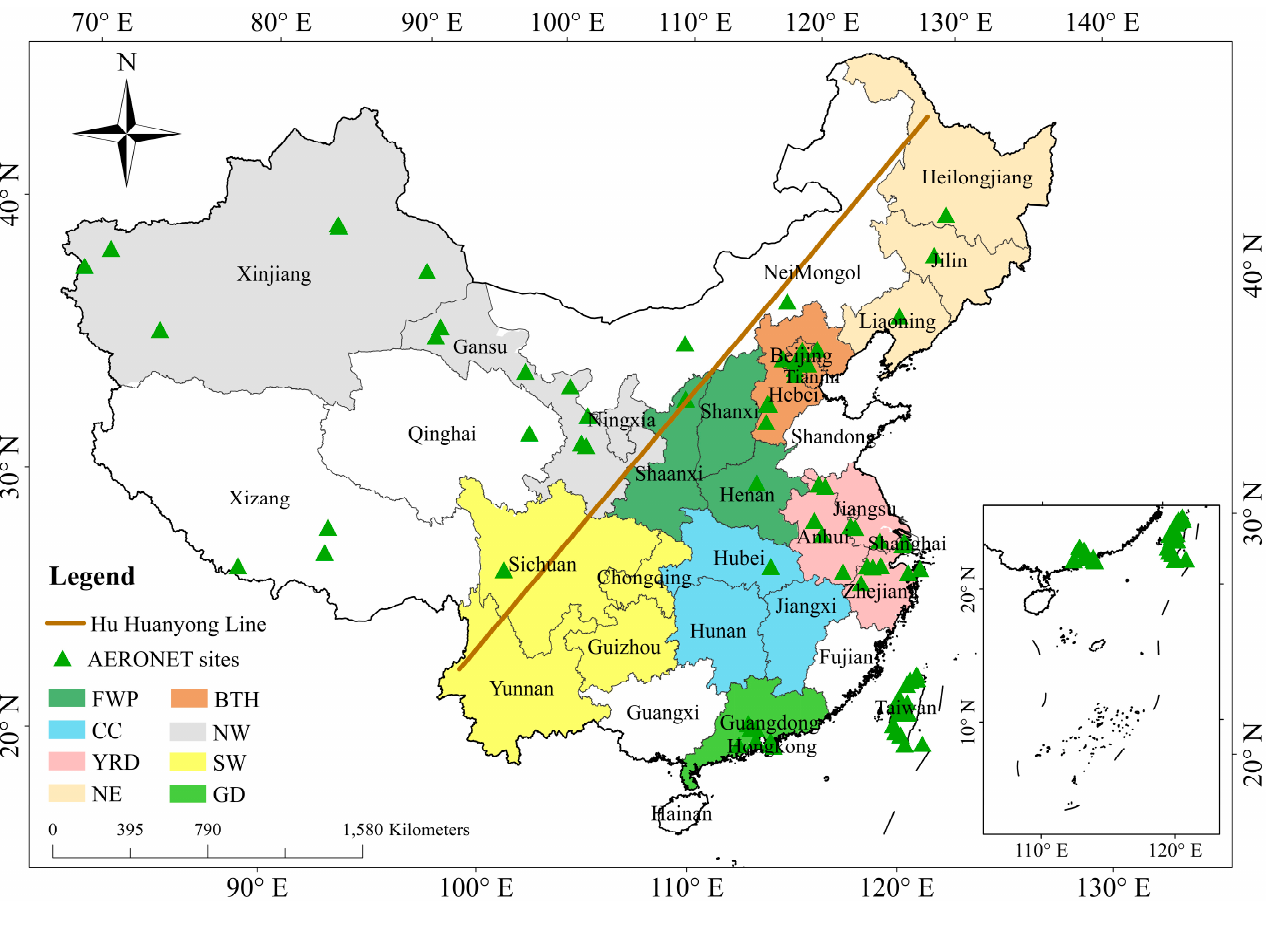
Figure 1. Map of Study Area. Table 1. Administrative districts of eight major